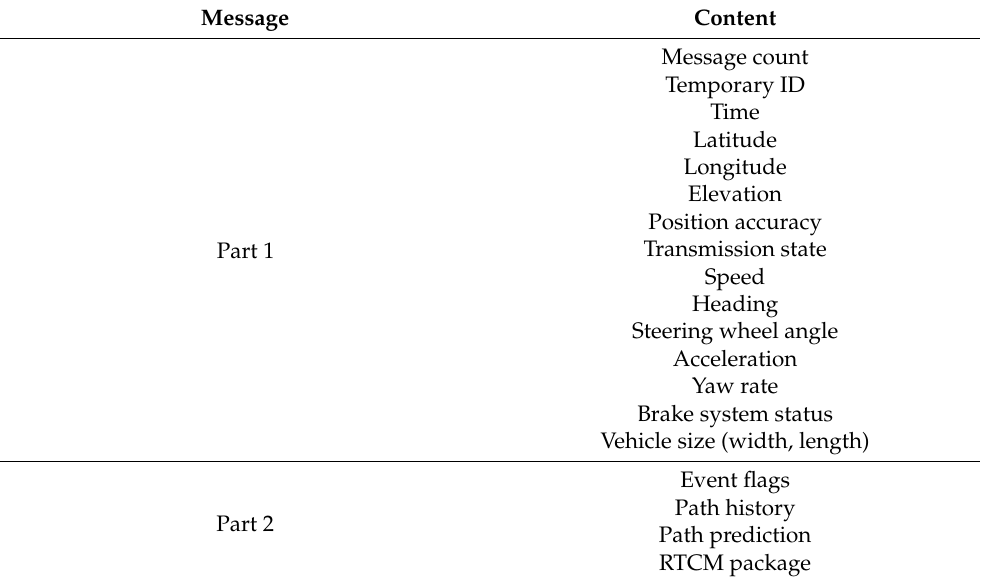
Table 1. SAE J2735